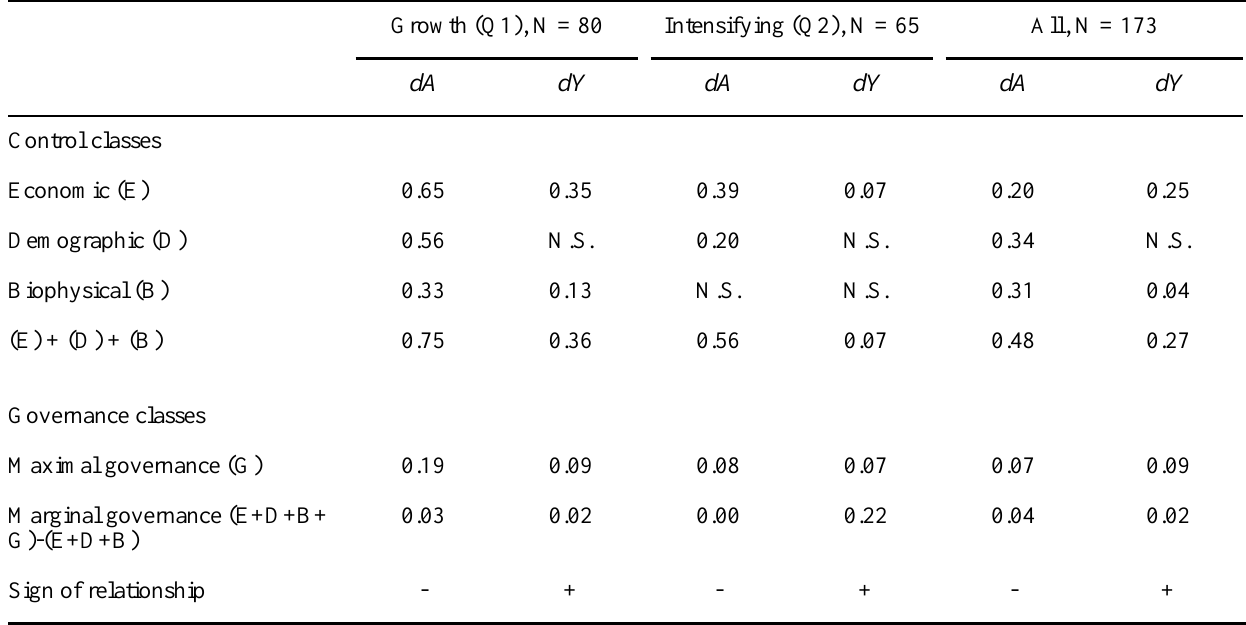
Table 3. Variance explained (R2) by classes and combinations of classes, per quadrant and dependent. dY is the log of relative change in yield at national level, and dA the log of relative change in cultivated area at national level. N.S. = Not Significant. Sign of relationship refers to whether dA or dY decreases (negative) or increases (positive), upon increasing the quality of governance in the maximal governance class regression equations. Statistical software: R for statistical computing version 2.8.0